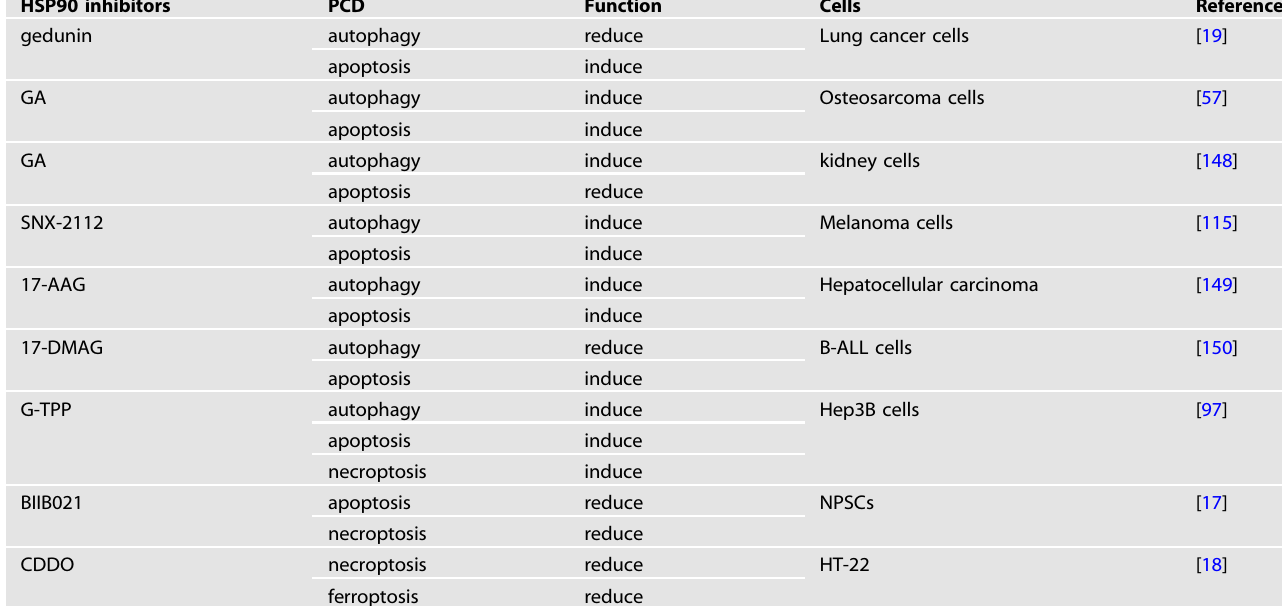
Table 2. HSP90 inhibitors regulated multiple PCD